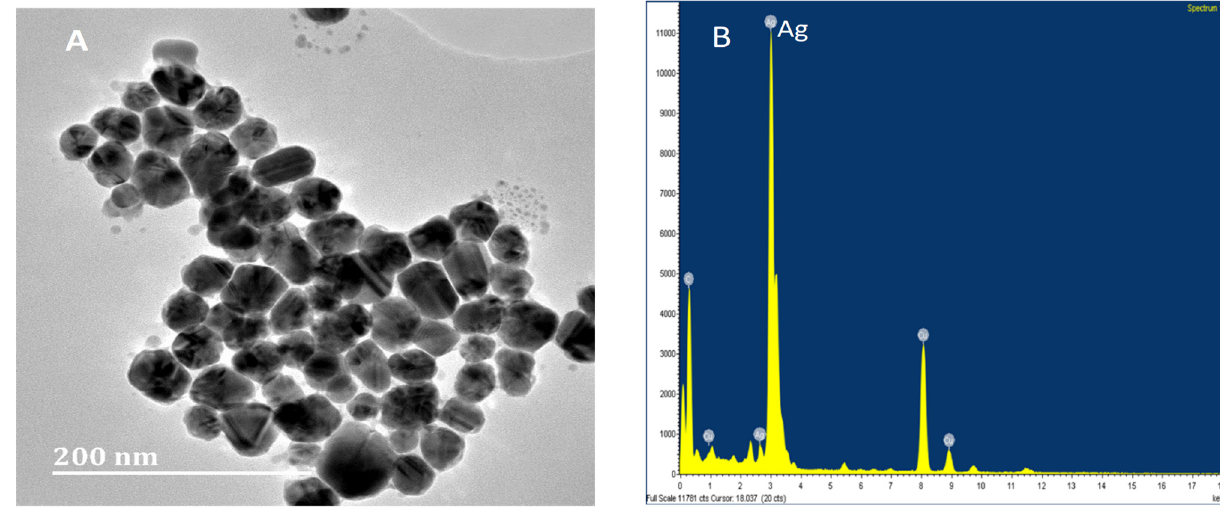
Figure 1. Analysis of chemical synthesis of silver nanoparticles. Images showing the TEM picture of silver nanoparticles ( A ) and EDX pattern ( B ).